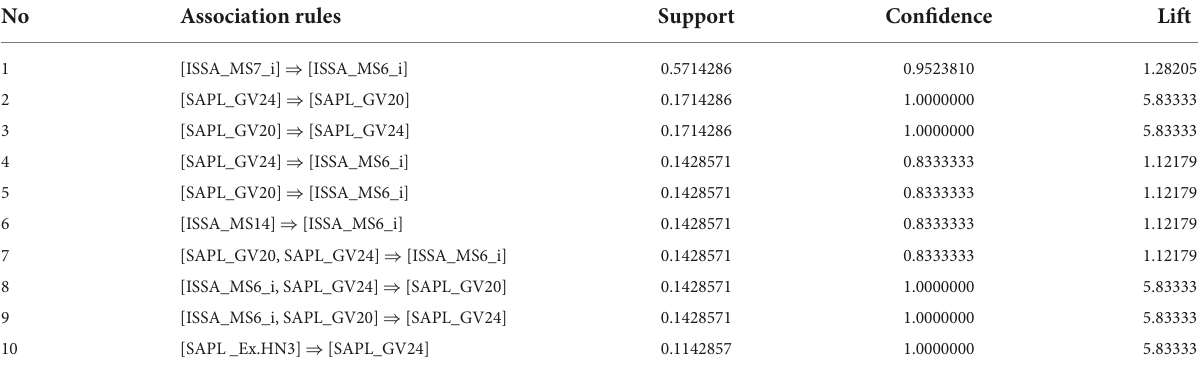
TABLE 2 Top 10 Apriori algorithm-based association rules of the scalp acupuncture